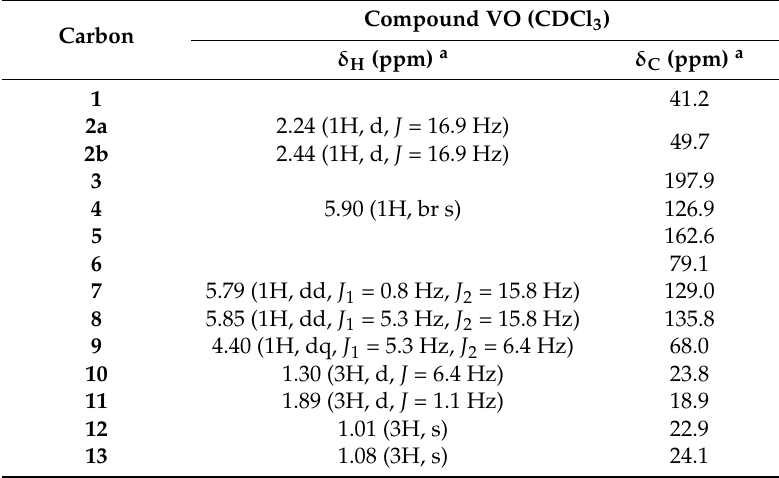
Table 3. 1 H- (600 MHz) and 13 C-NMR (151 MHz) data for compound VO